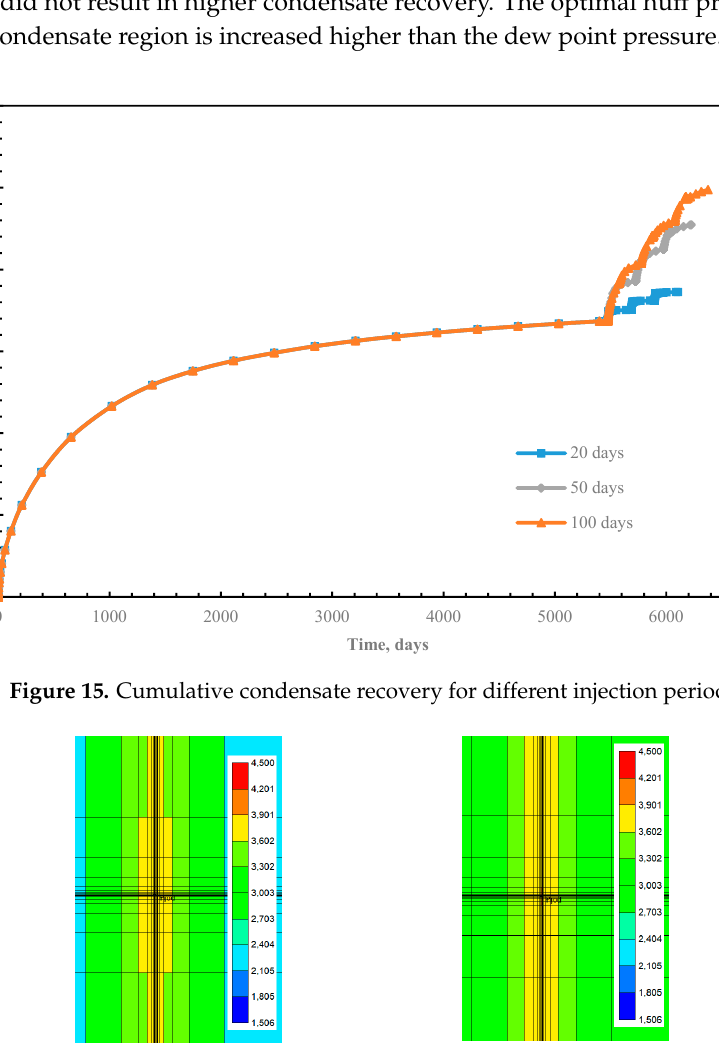
Figure 14. Pressure distribution for different injection pressure. ( a ) Injection pressure: 2500 psi; ( b ) Injection pressure: 3000 psi; ( c ) Injection pressure: 3500 psi; ( d ) Injection pressure: 4000 psi.